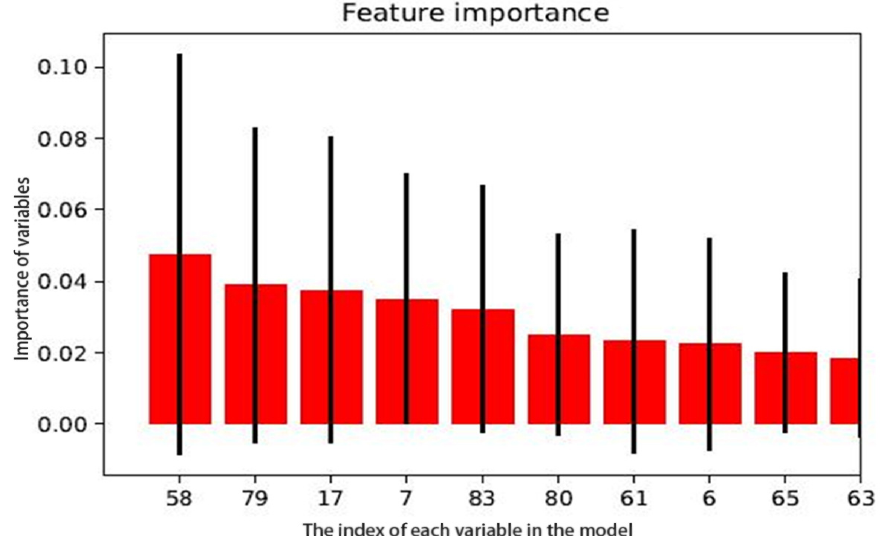
Figure 3. Importance scores of random forest model variables. ID58:PH, ID79: Lac > 1.9 mmol/L, ID17: false cavity area > 11.85 cm 2 , ID7: ventilator assisted ventilation, ID83: respiratory rate, ID80: